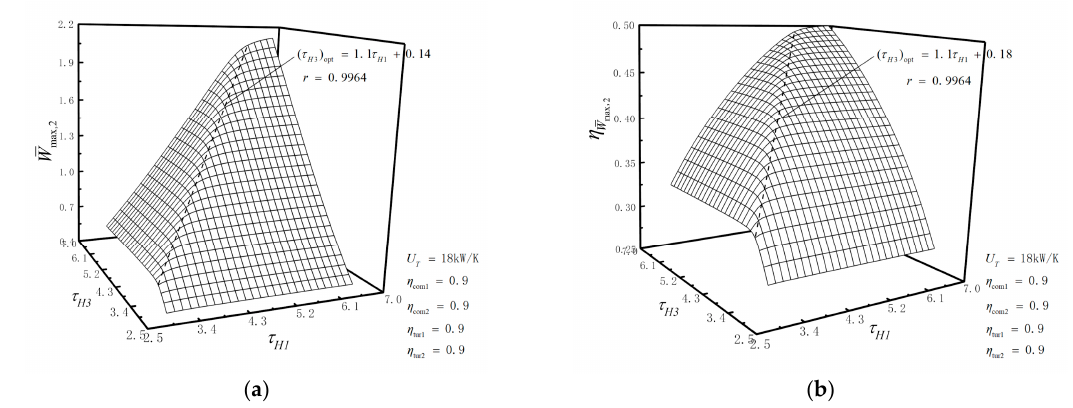
τ and τ ; ( b ) relationships of 1 H 3 H